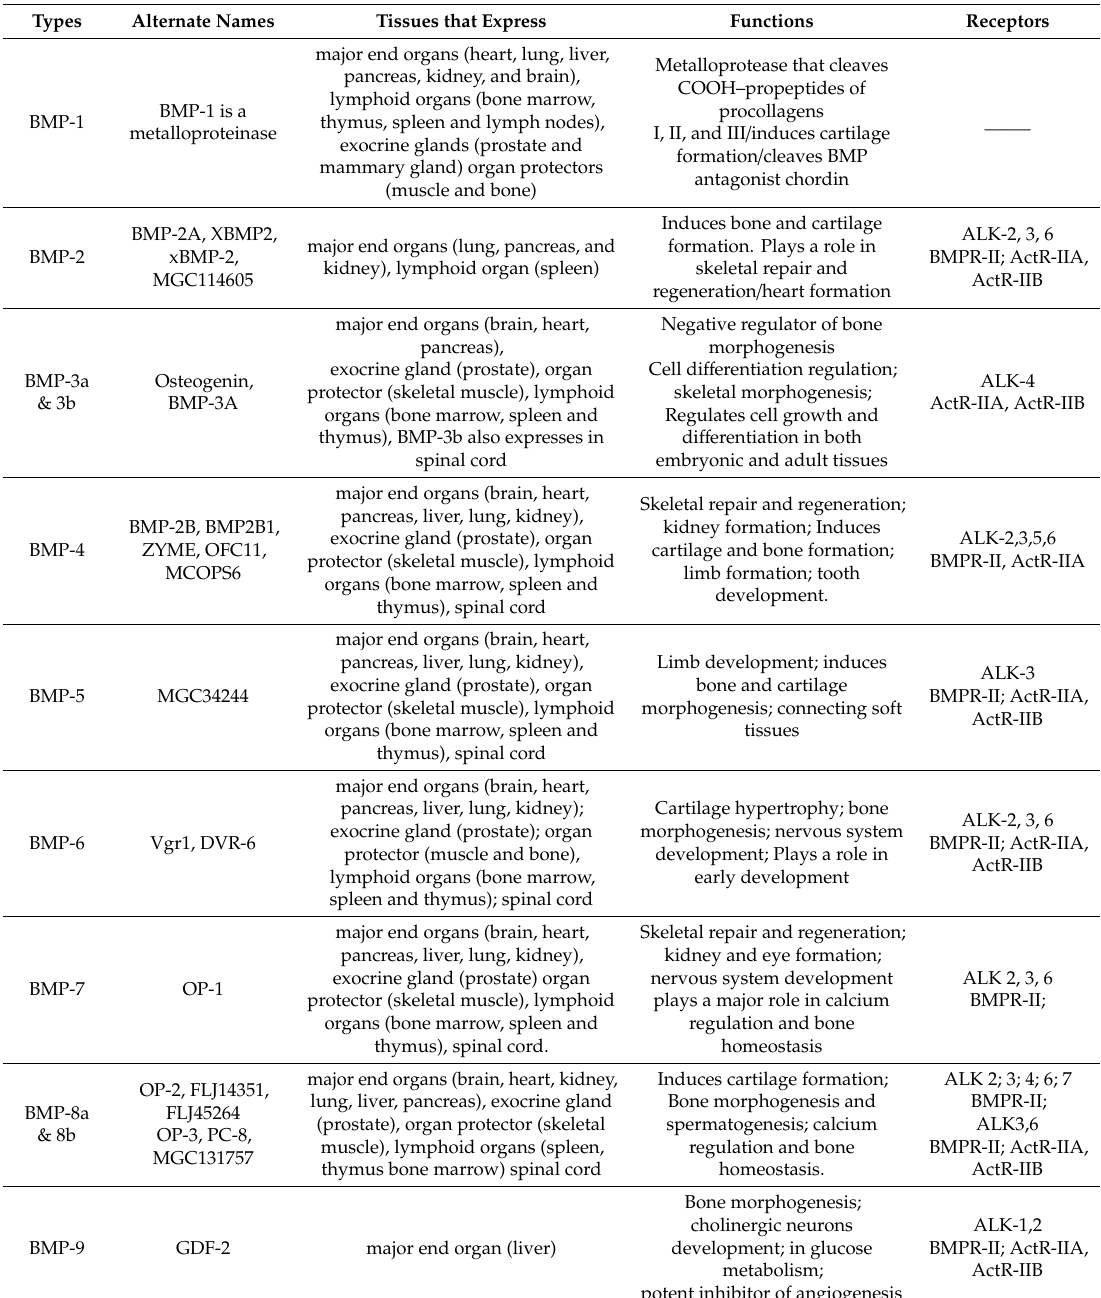
Table 1. Types of bone morphogenetic proteins (BMPs) and their